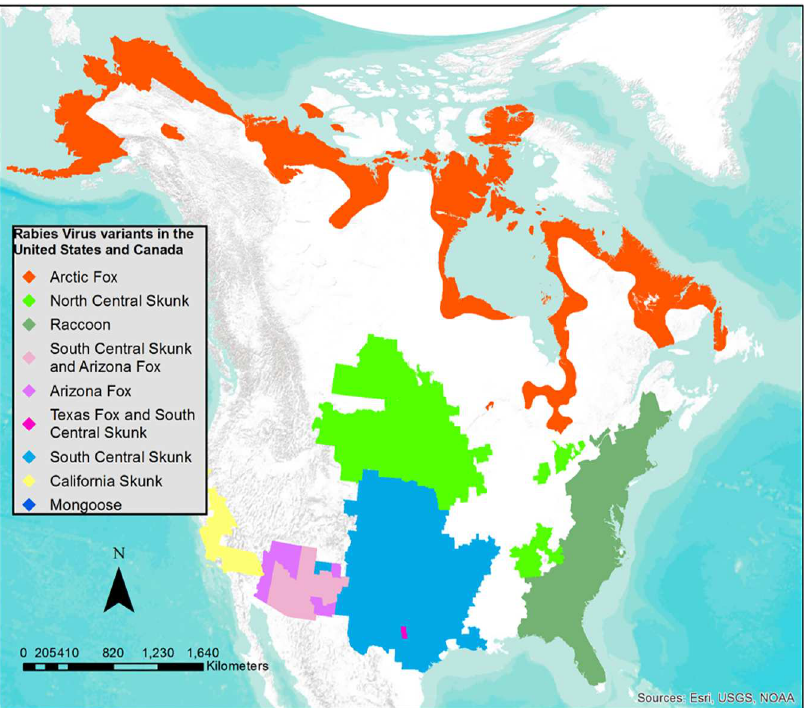
Fig 1. Current geographic distribution of rabies virus variants in the continental US and